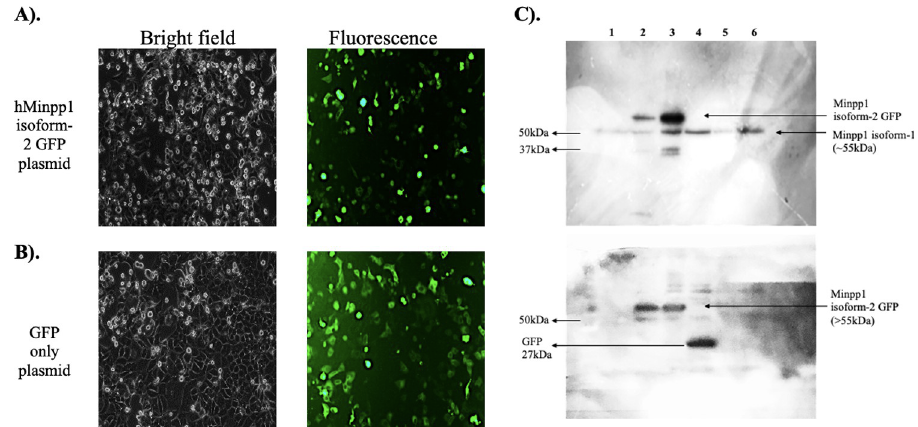
Fig 6. Plasmid Expression analysis: Bright field and fluorescence images of MCF-7 breast cancer cells successfully transfected and incubated 24h with A). Minpp1 isoform-2 plasmid (GFP tagged), B). GFP only plasmid. C). Positively transfected cells were lysed, and SDS-PAGE resolved proteins were transferred onto nitrocellulose membrane to further immuno-stain with anti-Minpp1 polyclonal antibody (upper blot) and anti-GFP monoclonal antibody (lower blot). Results show that the polyclonal antibody raised against Minpp1 isoform-1 also shared its epitope with Minpp1 isoform-2. GFP MW: 27kDa. Lane-1, 5 & 6: Control cell lysate (CL), Lane-2 & 3: Minpp1 isoform-2 GFP CL, Lane-4: GFP alone